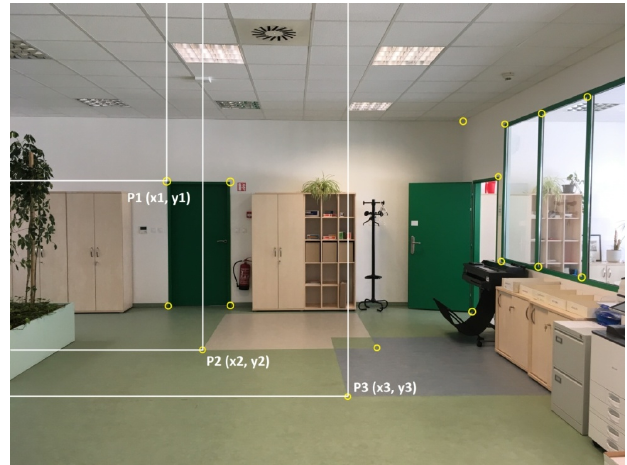
Figure 3. Distribution of ground control points in the database image.